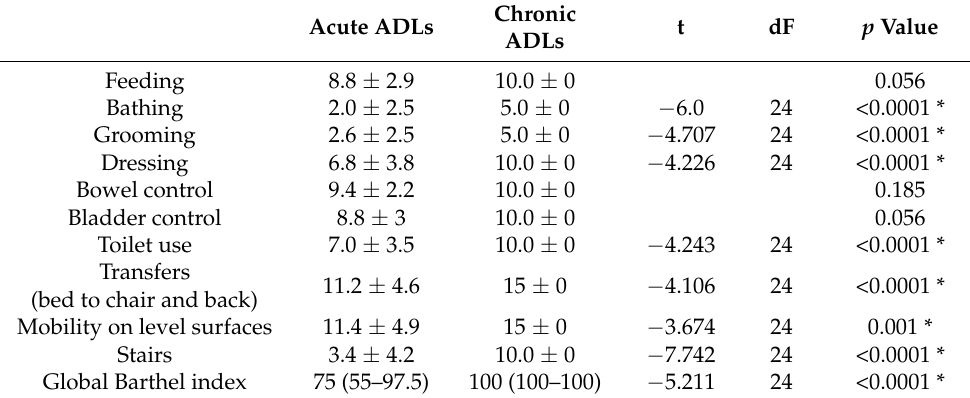
Table 2. Acute and chronic ADLs (Barthel index).